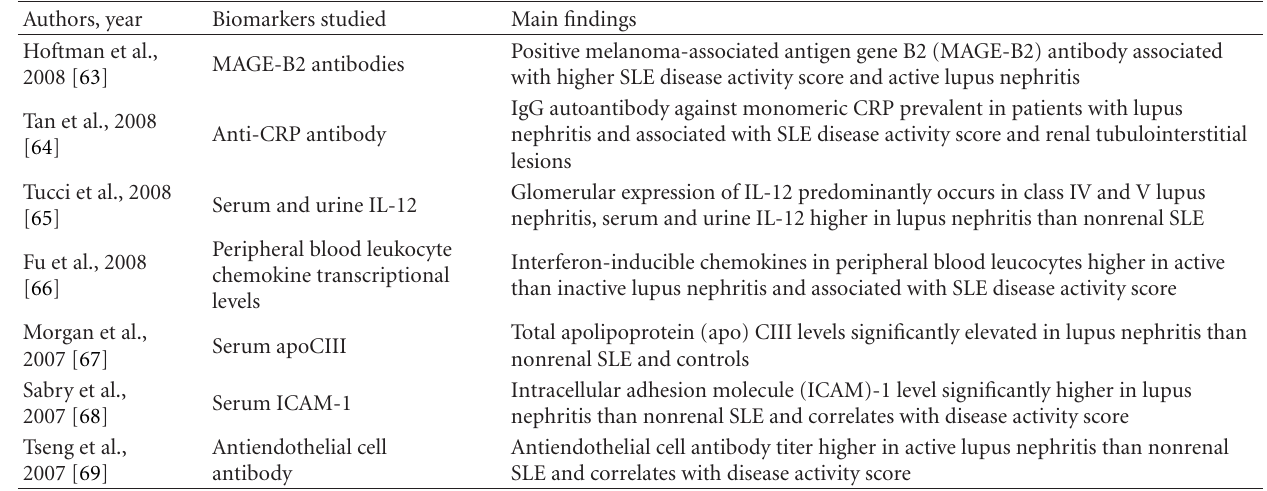
Table 1: Serum biomarkers that correlate with lupus nephritis activity in cross-sectional studies.